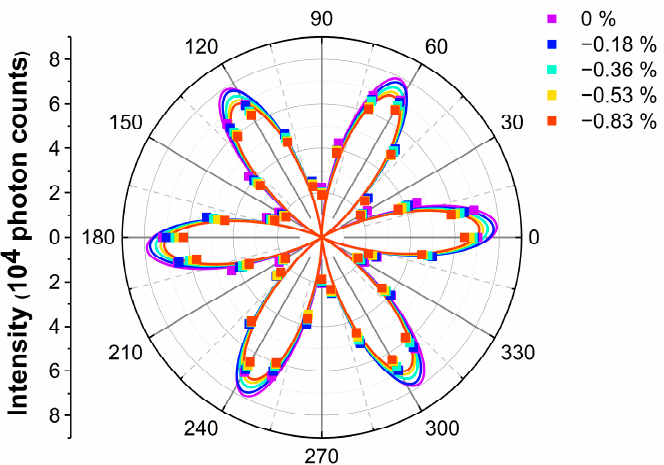
Figure 2. Normalized angle-resolved SHG patterns for SHG polarization parallel (blue squares) and perpendicular (orange dots) to the incident light polarization. The blue and orange solid lines are cos (cid:2870) 3𝜃 and sin (cid:2870) 3𝜃 curves, respectively.